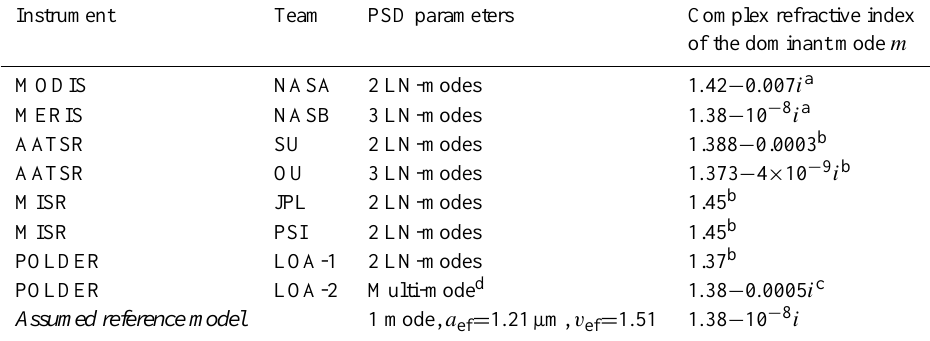
Table 3. The aerosol models retrieved using diverse algorithms and instruments. The parameters of the reference model are also given. Instrument Team PSD parameters